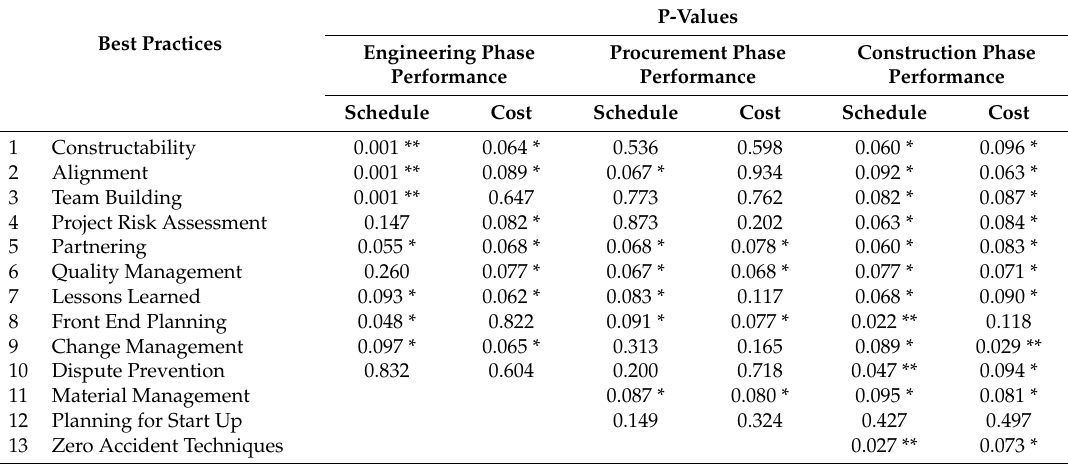
Table 8. Significance Level of each Best Practices with all Engineering, Procurement, and Construction (EPC)